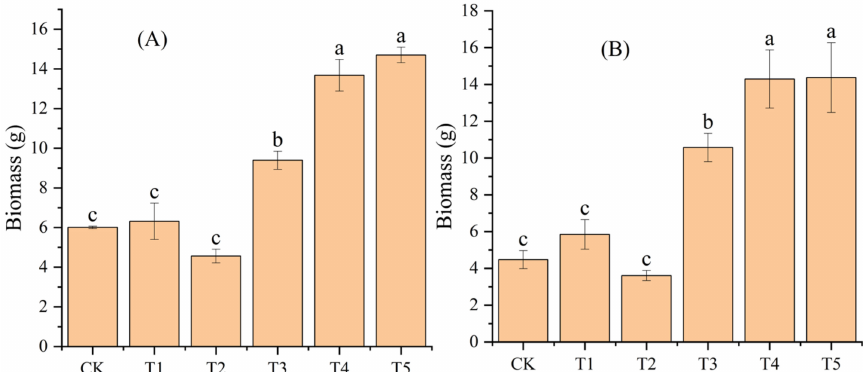
Figure 2. Effects of different treatments on leaf ( A ) and branch ( B ) biomass of moso bamboo seedlings. CK: no biochar and no N addition; T1: 0.64% biochar + 0% NH 4 NO 3 ; T2: 1.28% biochar + 0% NH 4 NO 3 ; T3: 0% biochar + 1.28% NH 4 NO 3 ; T4: 0.64% biochar + 1.28% NH 4 NO 3 ; T5: 1.28% biochar + 1.28% NH 4 NO 3 . Bars (standard deviation) with different lowercase letters are significantly different at p < 0.05.